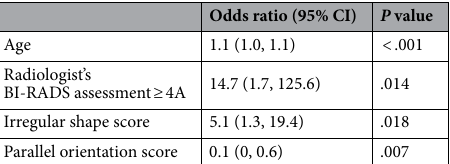
Table 3. Multivariable logistic regression analysis for predicting malignancy. BI-RADS, Breast Imaging Reporting and Data System; CI, confidence